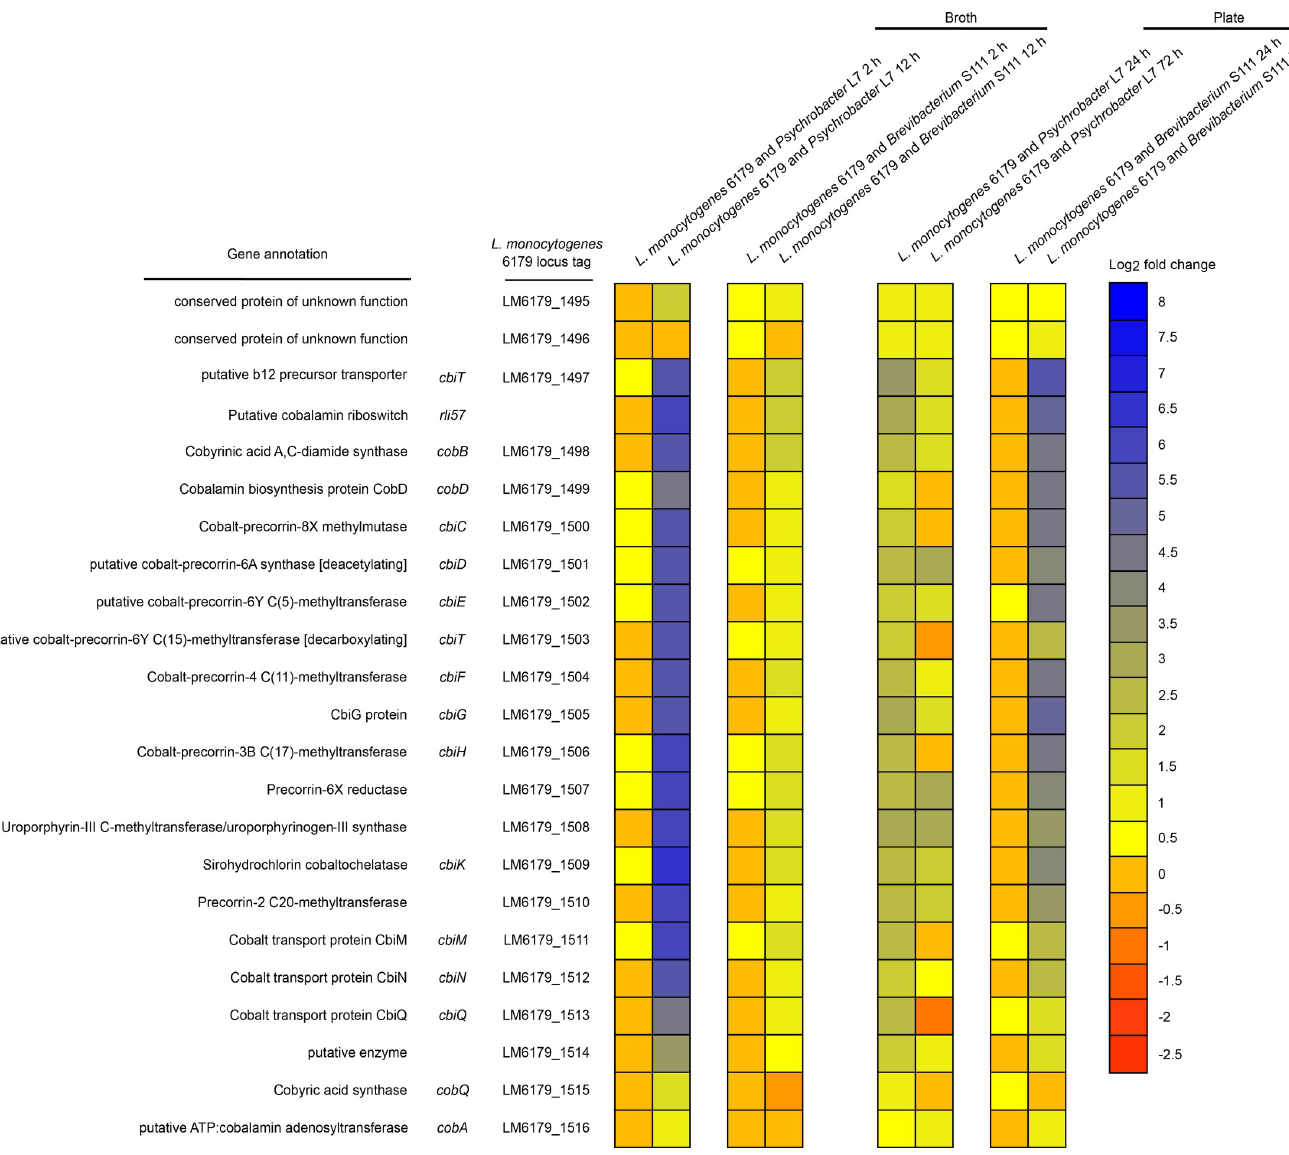
PLOS ONE | https://doi.org/10.1371/journal.pone.0233945 July 23,